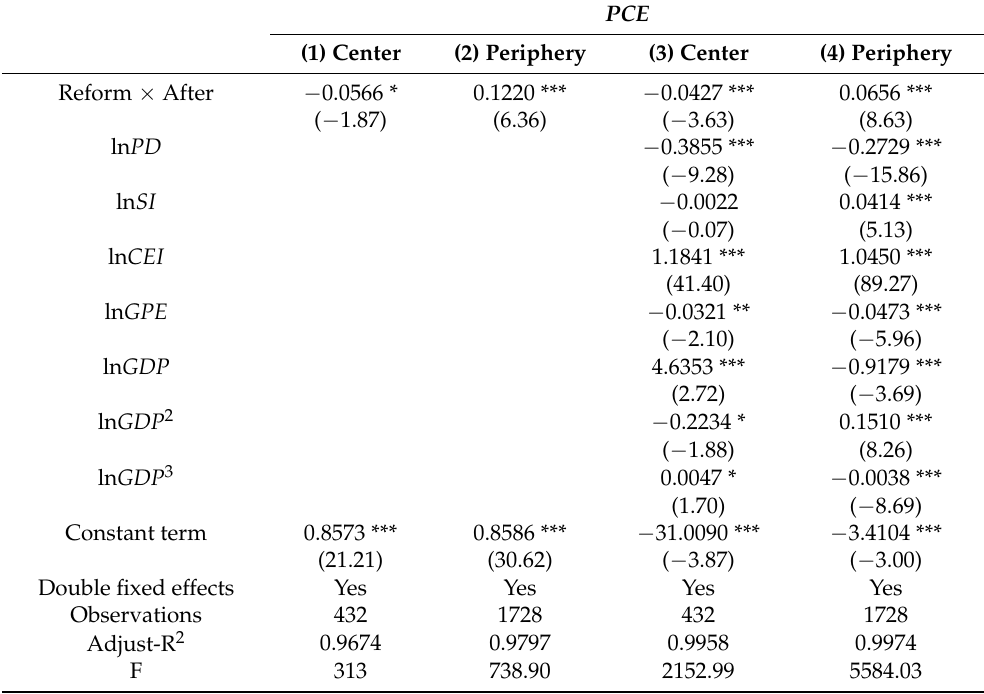
Table 4. Regional heterogeneity effects of reform.